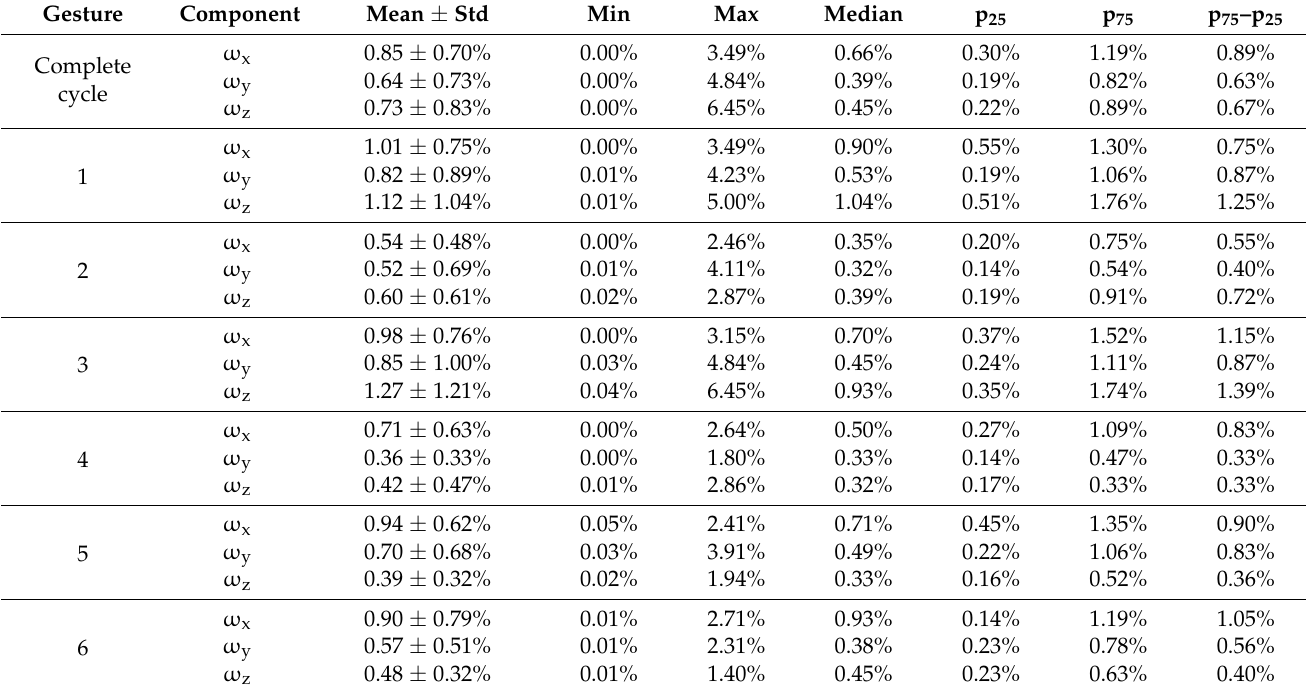
Table 8. Descriptive statistics obtained based on the gyroscope